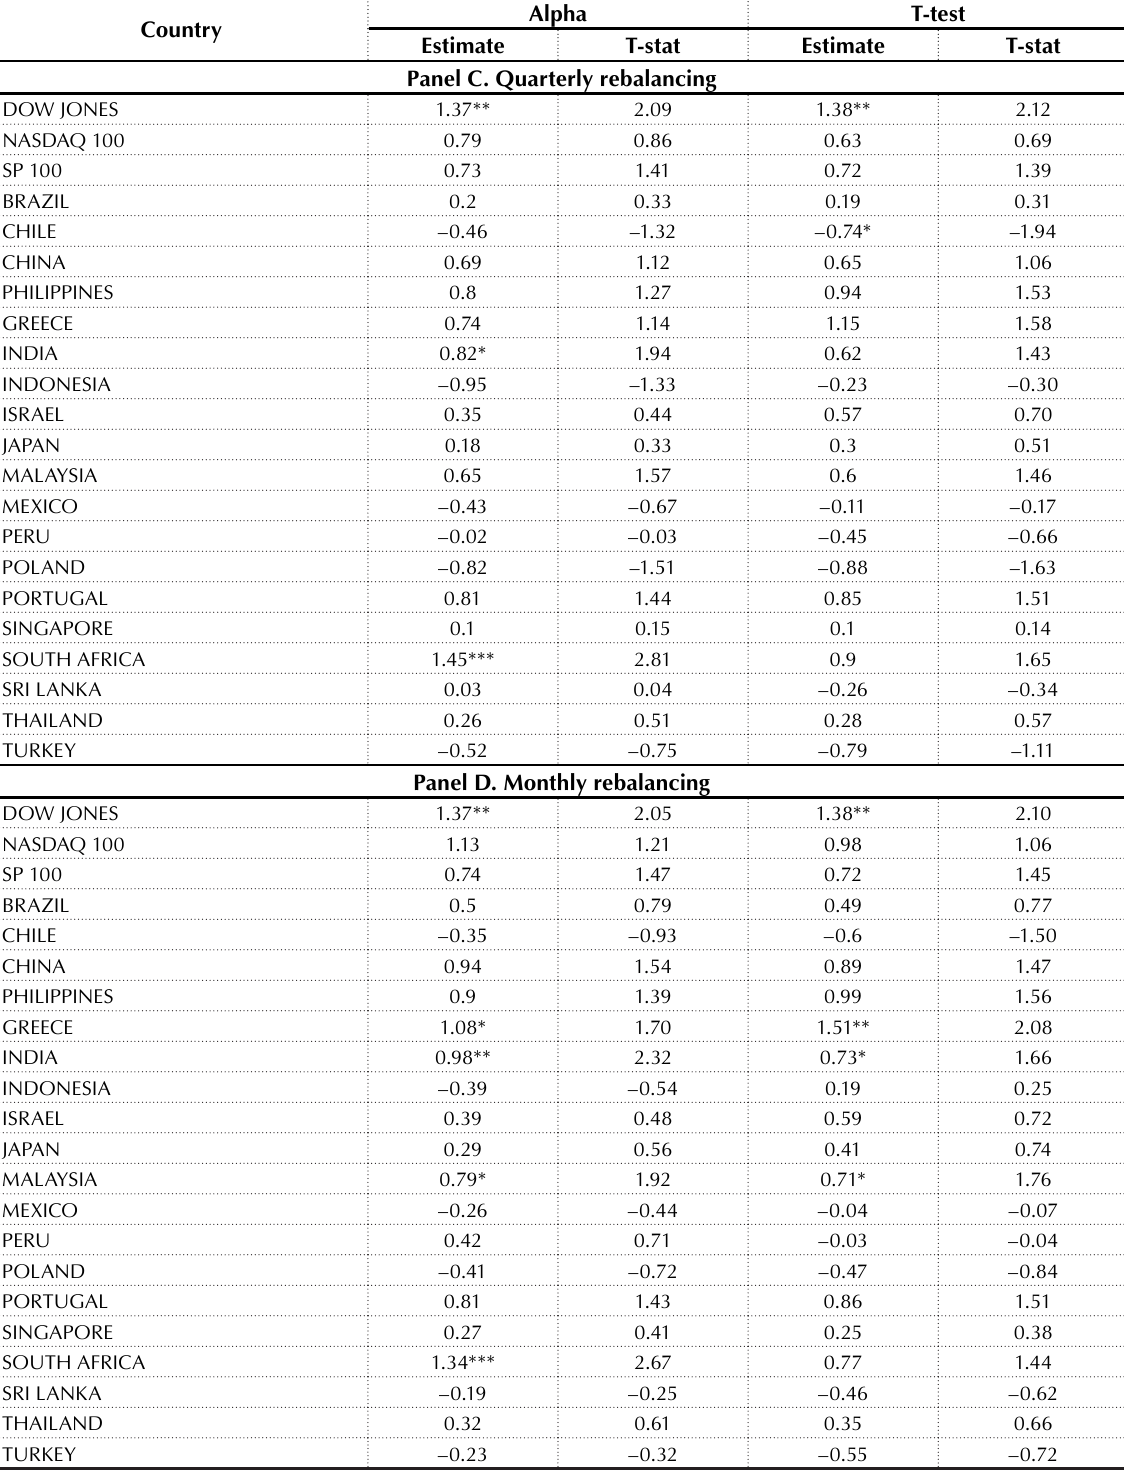
Table 3 (cont.). Statistical tests of performance of mean-variance optimized portfolios Alpha T-test Country Estimate T-stat Estimate T-stat Panel C. Quarterly